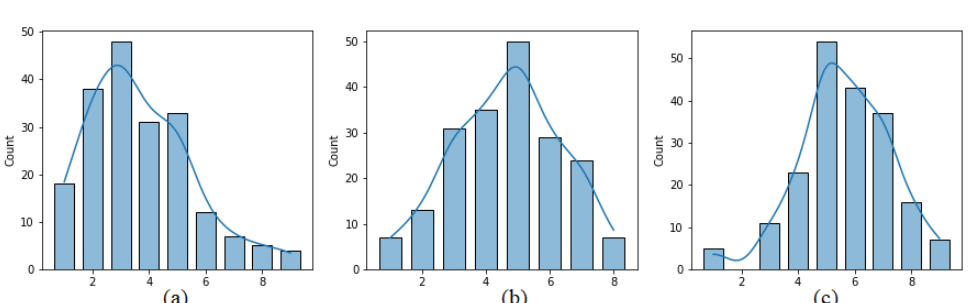
Figure 3. Distribution of ( a ) pleasure, ( b ) arousal and ( c ) dominance